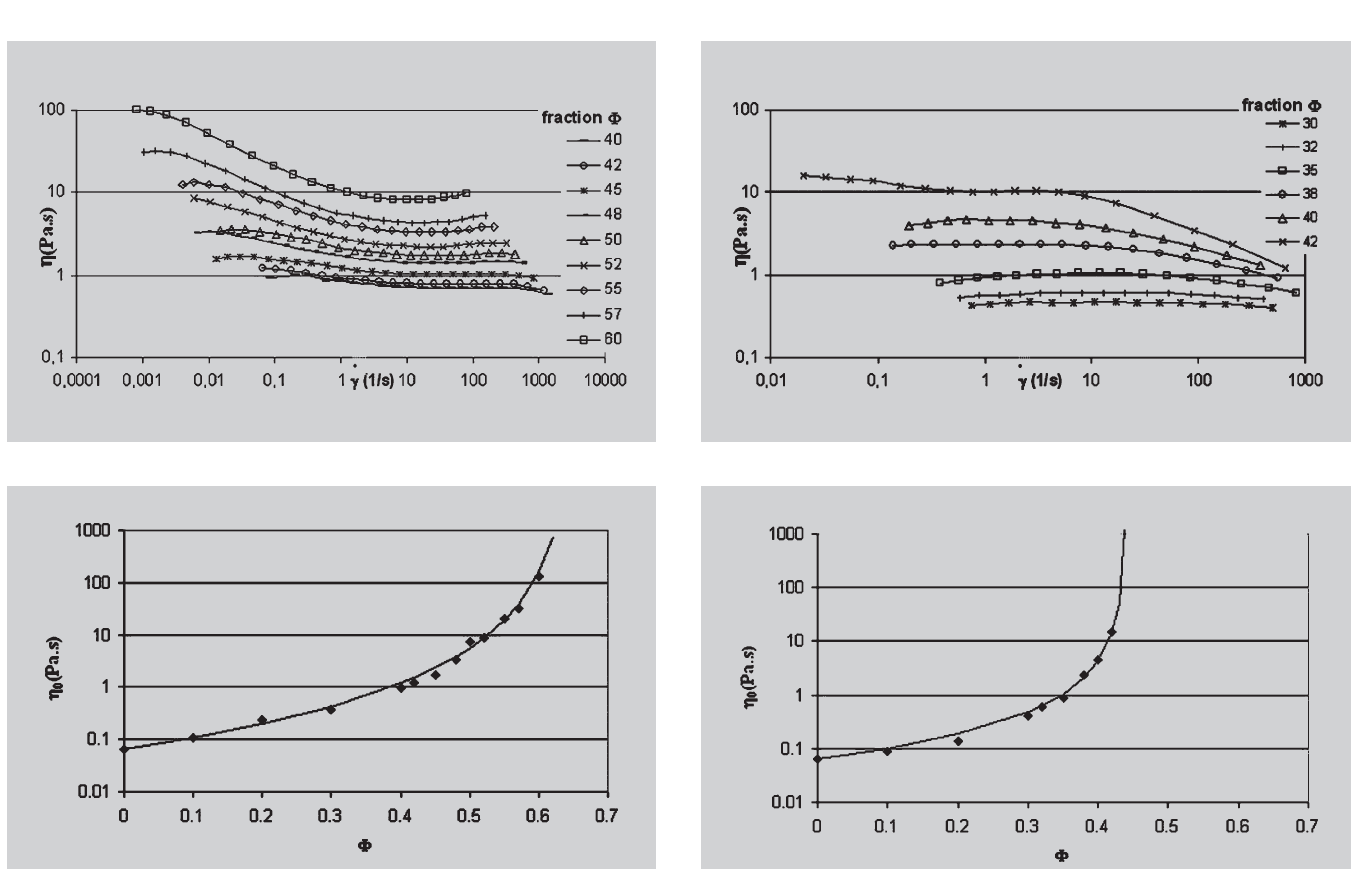
Figure 4 (left above): Rheological curve for plasti- sols-A. Variation of the vis- cosity versus shear rate at room temperature. Figure 5 (right above): Rheological curve for plasti- sols-B. Variation of the vis- cosity versus shear rate at room temperature. Figure 6 (left below): Variation of the zero shear viscosity versus the total volume fraction F of plasti- sols-A. Experimental data vs Krieger model. Figure 7 (right below): Variation of the zero shear viscosity versus the total volume fraction F of plasti- sols-B. Experimental data vs Krieger